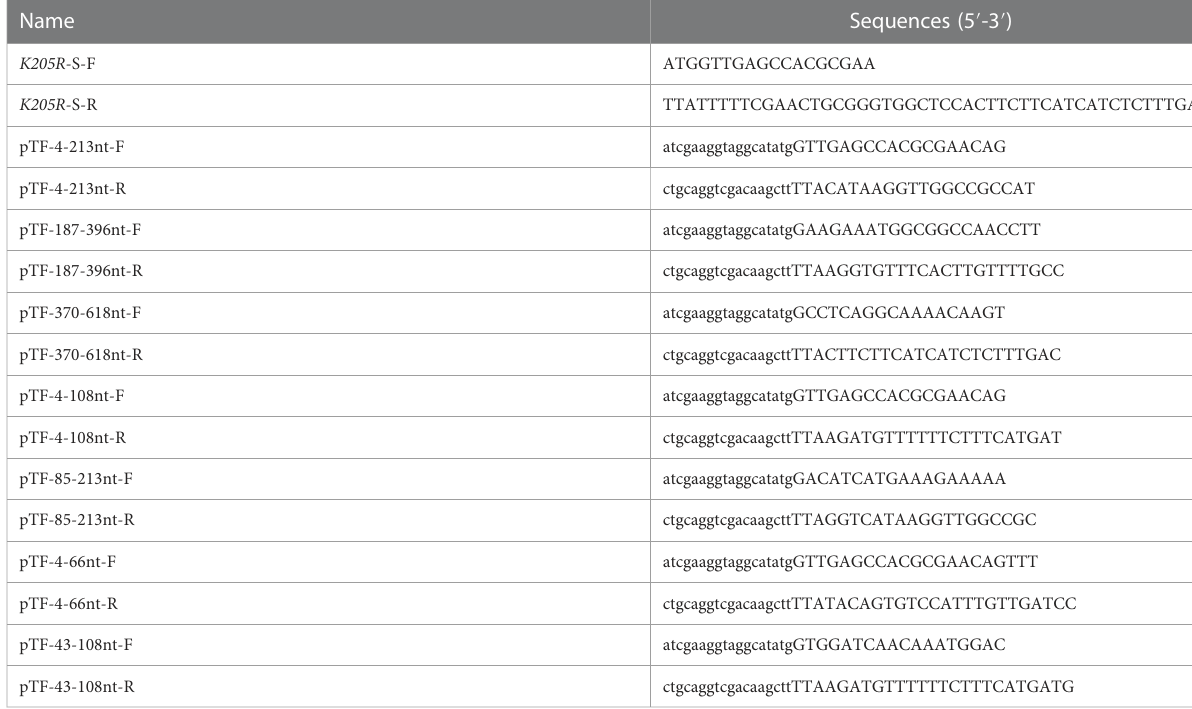
TABLE 1 Primers for the truncated protein of pK205R.